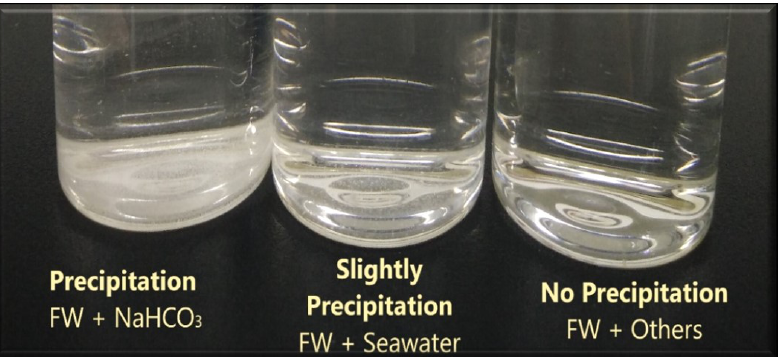
Figure 13. The results of the compatibility test ( CT ) between synthetic formation water and our designed smart water (SW)